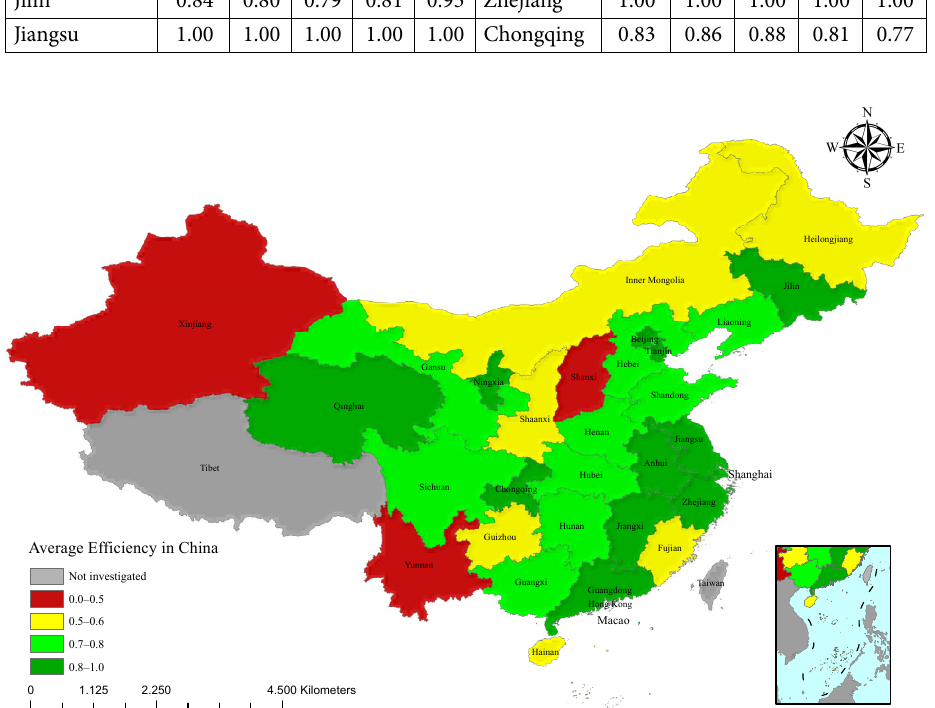
Figure 2. Mean theoretical and application innovation